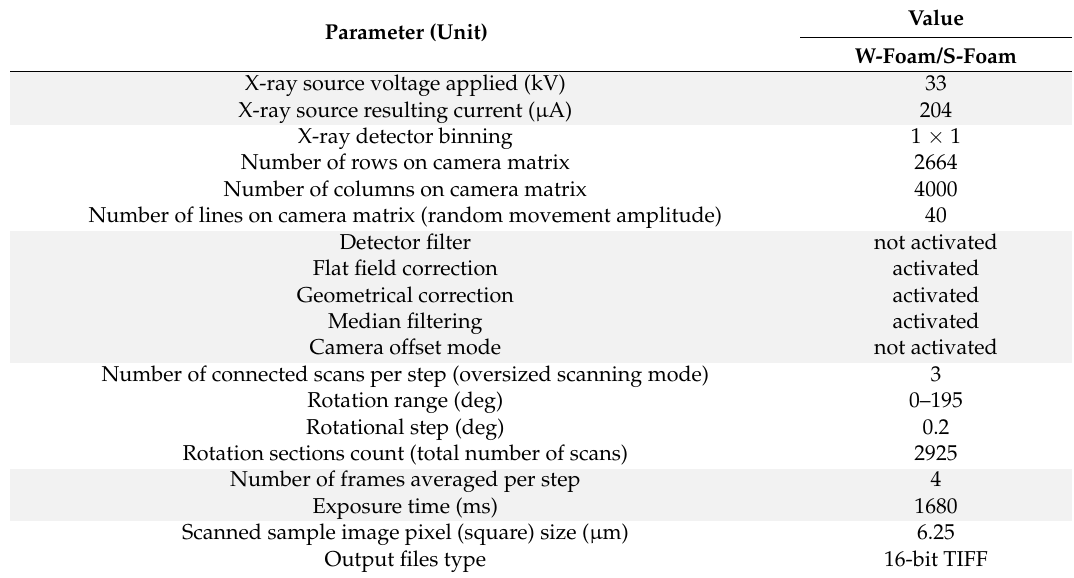
Table 5. The most optimal scanner settings found for data